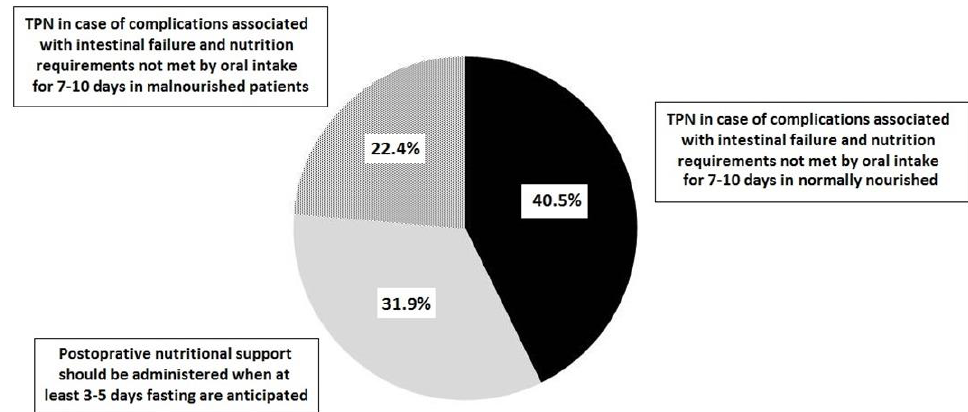
Figure 1. Percentages of responses to the question “which of the following statements regarding postoperative nutritional support is correct?” (TPN: total parenteral nutrition) (no answer 5.2%)